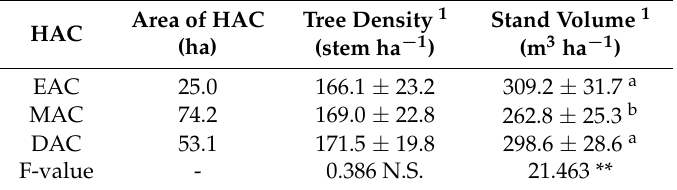
Table 4. Stand characteristics (average ± SD) in the human accessibility classes